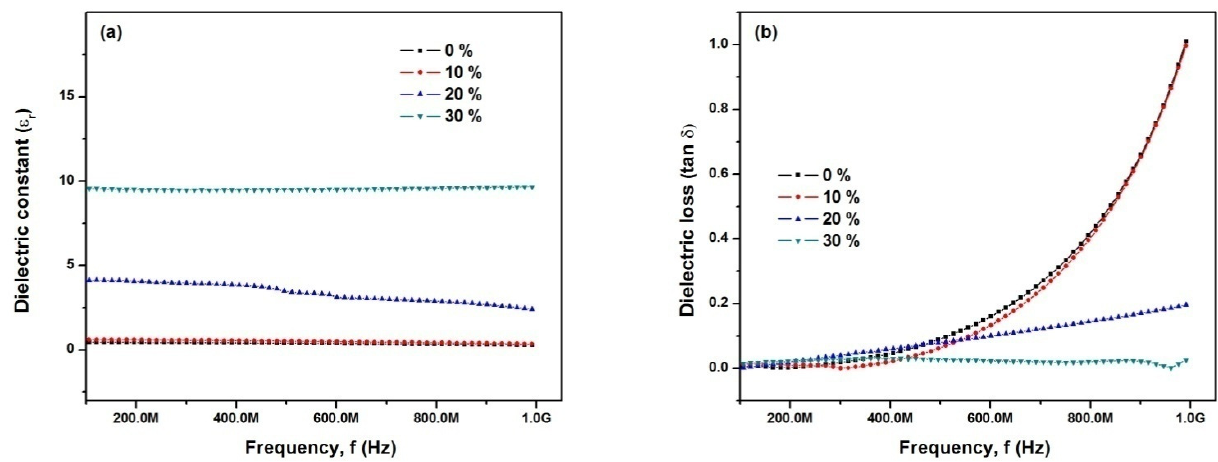
Figure 6. ( a ) Variation in dielectric constant ( ε r ) with frequency (f) ( b ) Variation in dielectric loss (tan δ ) with frequency (f) for various BT content.